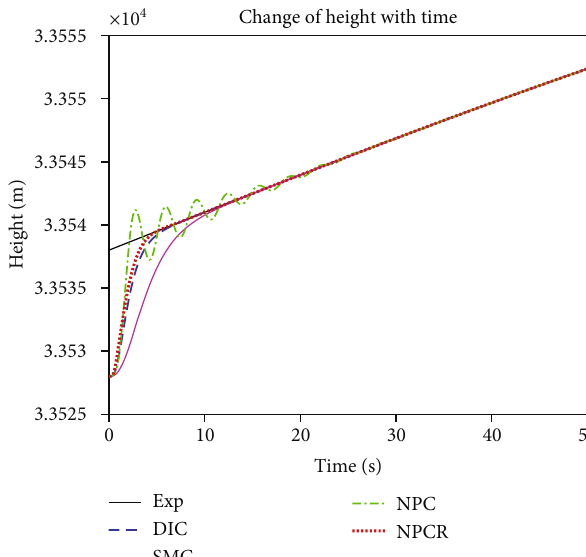
Figure 4: Height changes with time under di ff erent controllers.